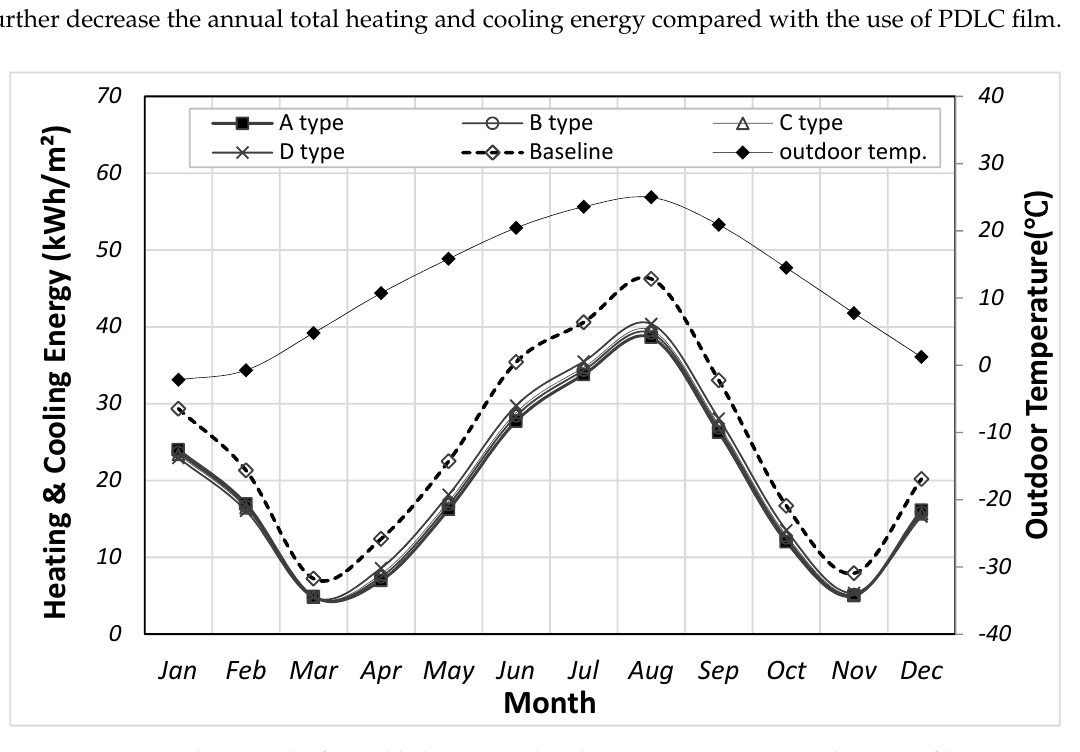
Figure 12. Analysis result of monthly heating and cooling energy consumption by PDLC film type.